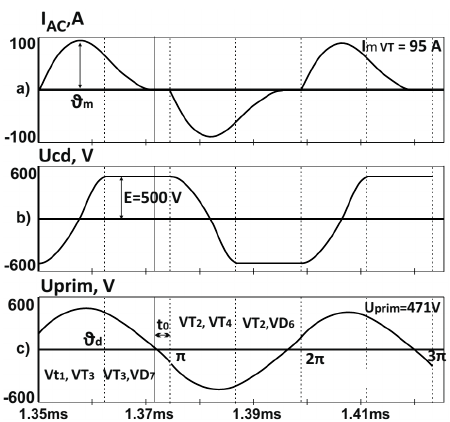
Figure 8. Basic time charts of AI with ED at 35 kW output power and battery as a load: the current in inverter AC diagonal; the voltage of the dosing capacitor Cd; the voltage of the transmitting coil.